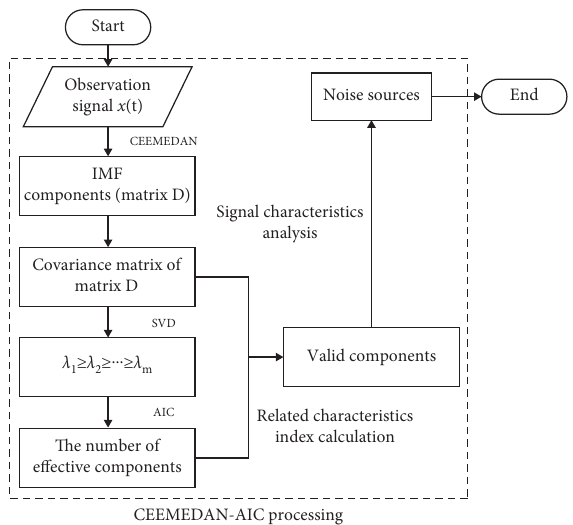
Figure 5: Flowchart of the CEEMDAN-AIC algorithm.